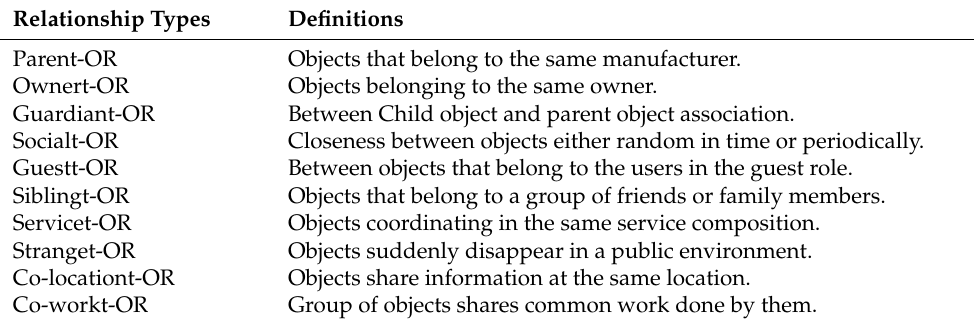
Table 1. Description of relationship